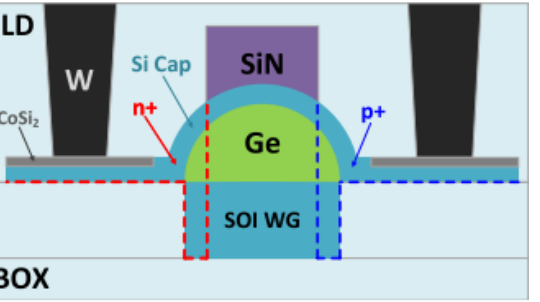
Figure 3. Typical lateral, germanium-integrated p-i-n photodiode (after [62]).